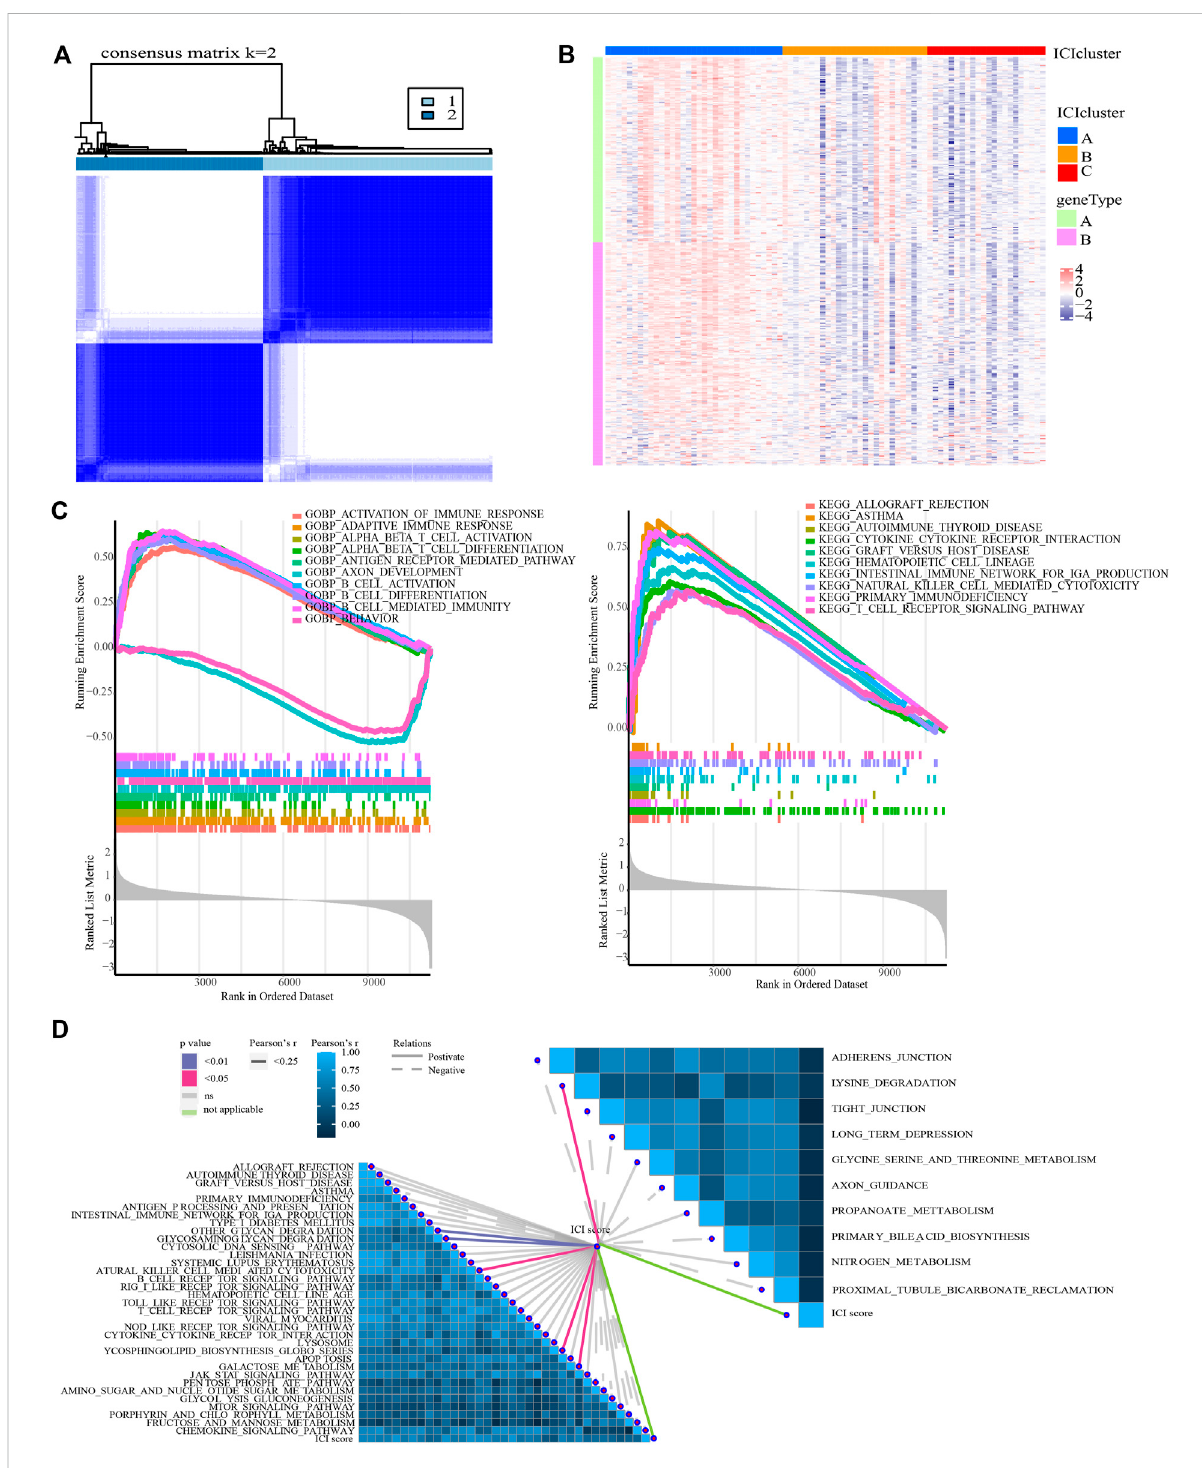
FIGURE 5 Identi fi cation of ICI gene clusters and ICI scores. (A) Consensus clustering matrix for k = 2 in PCNSL samples based on DEGs among ICI subtypes. (B) ExpressiontraitsofDEGsindifferentICIclustersandgeneclusters. (C) GSEAfortheenrichmentresultsinhighandlowICIscoregroups (ICI scores = PCA1a-PCA1b). (D) Correlation between ICI score and typical immune-related signaling